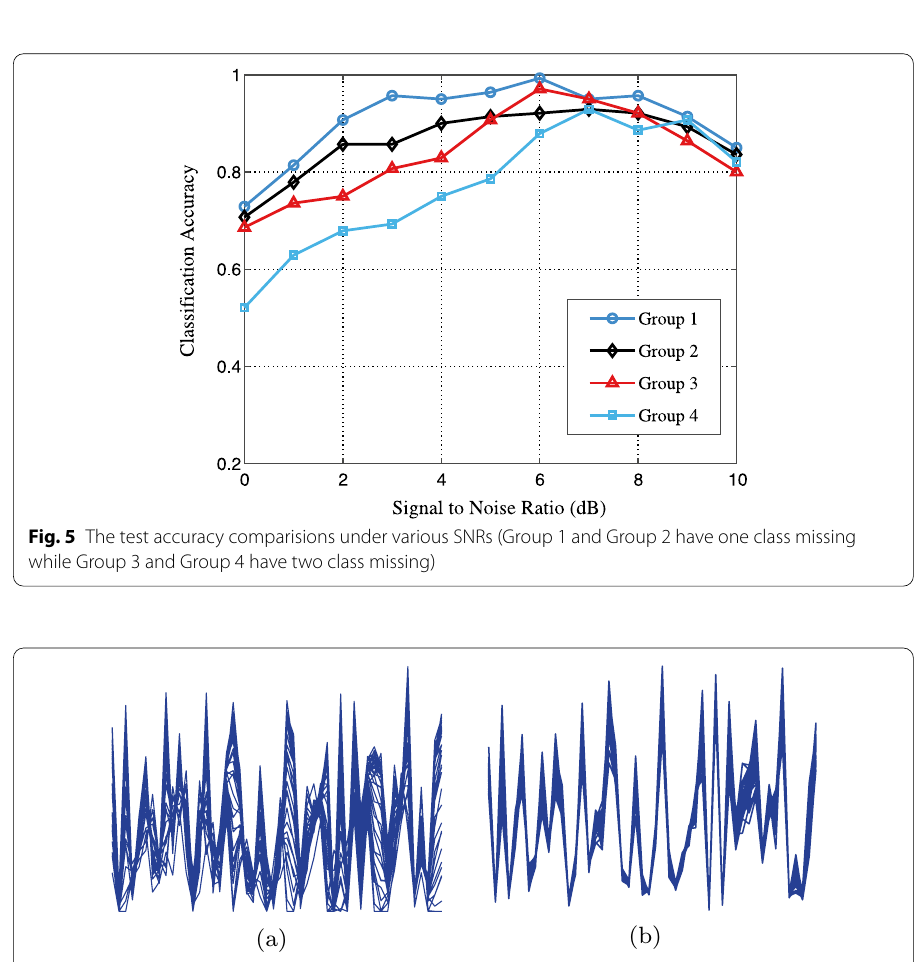
Fig. 6 The visualized feature vector: a The synthetic feature vector, b The real feature